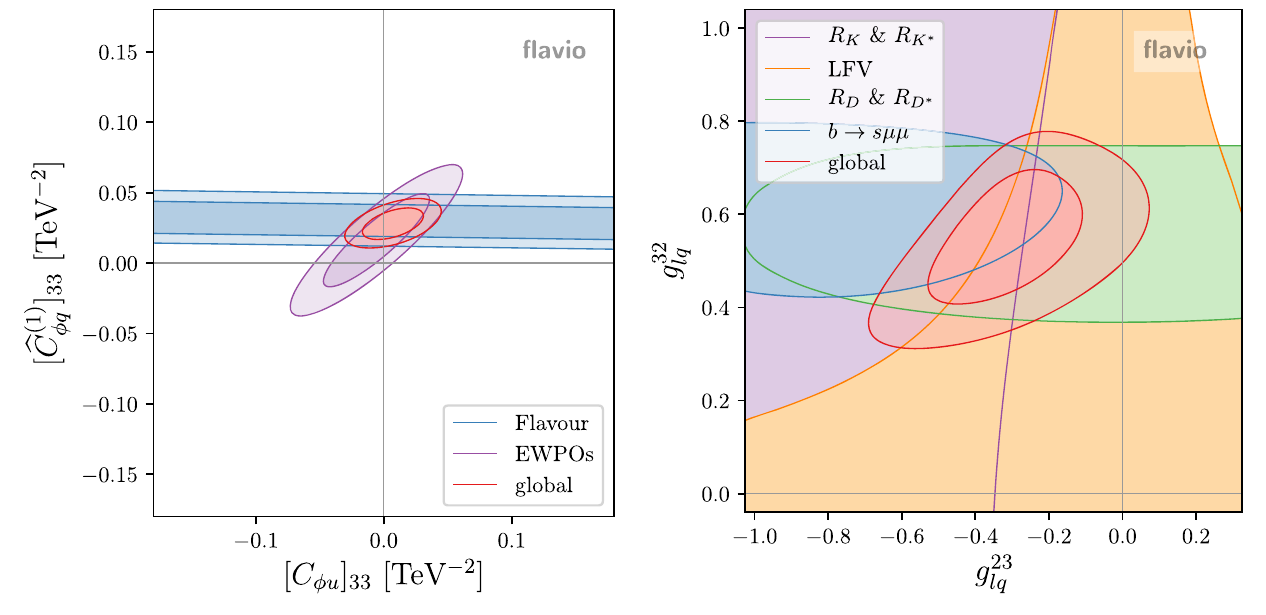
by B s → μ + μ − ) and EWPOs are complementary. Right: likelihood contours in the plane of the couplings g 23 leptoquark model at 1 σ level